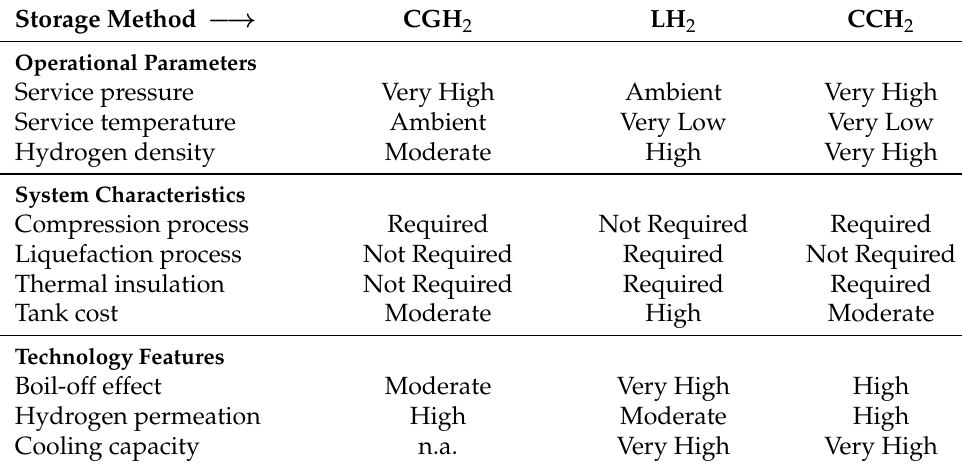
Table 2. Major features of physical hydrogen storage